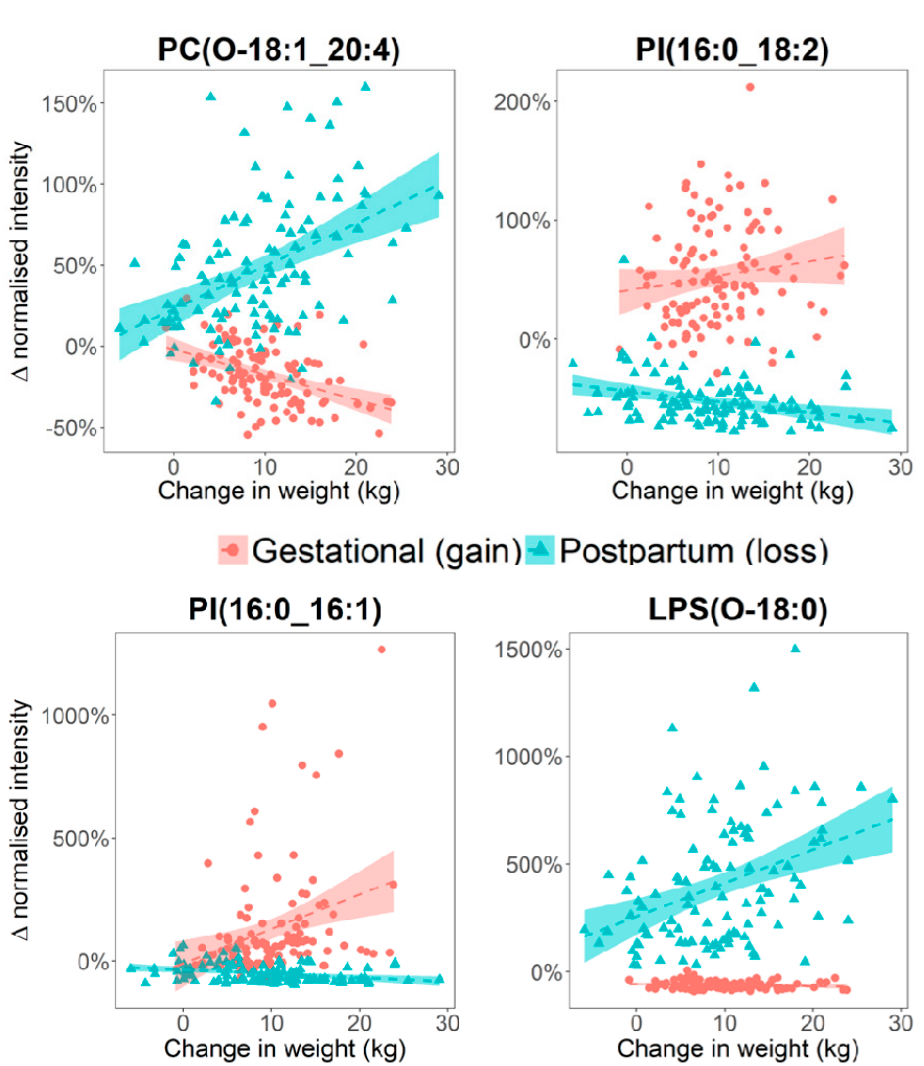
Figure 3. Scatter plots illustrating opposite direction of associations are observed between metabolite level, and GWG or WL. The Y-axes represent the change in metabolite intensity between the Baseline and WK35 (for GWG) or between the 1Y and W35 (for WL) samples, and these were calculated per-participant and expressed in percentage